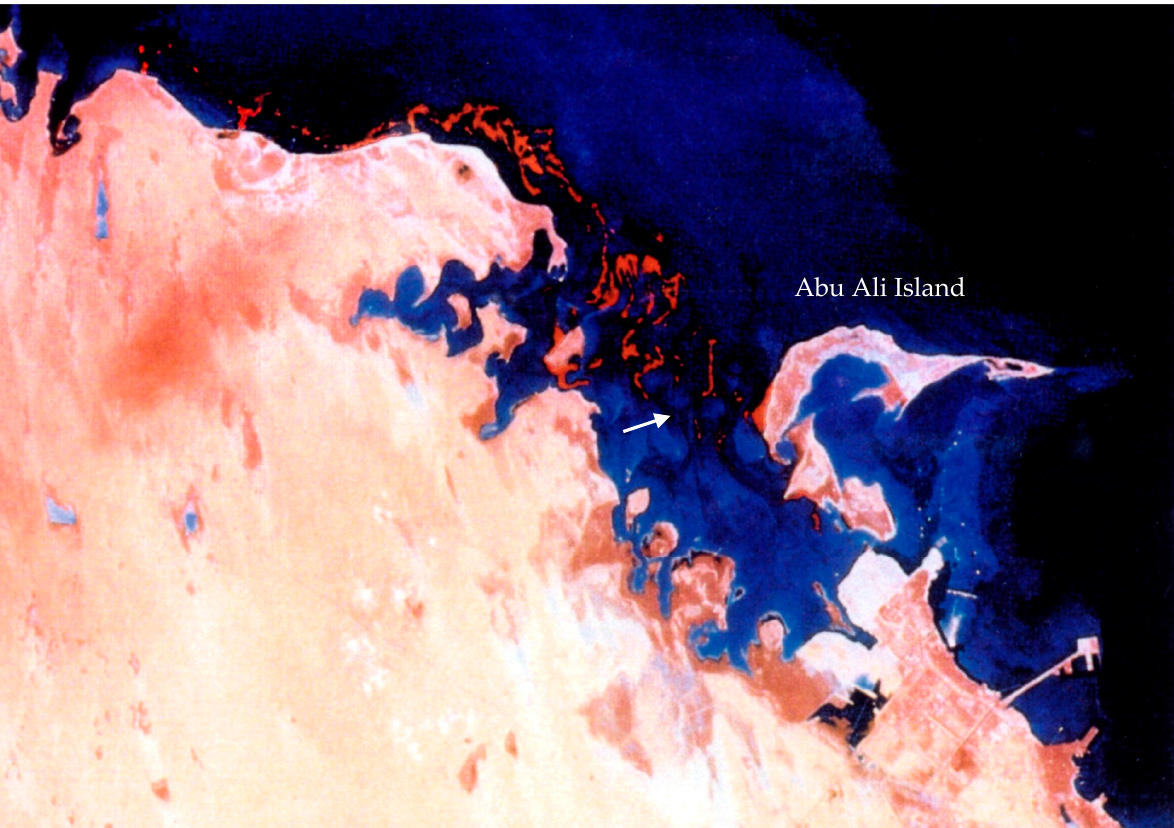
Figure 2. Landsat imagery taken on 16 February 1991 and processed to identify the oil slicks from the Gulf War oil spills in red. The white arrow points to the eastern extent of shoreline surveys in May/June 1991 to delineate the extent of the oil on the shoreline after the Gulf War oil spills.